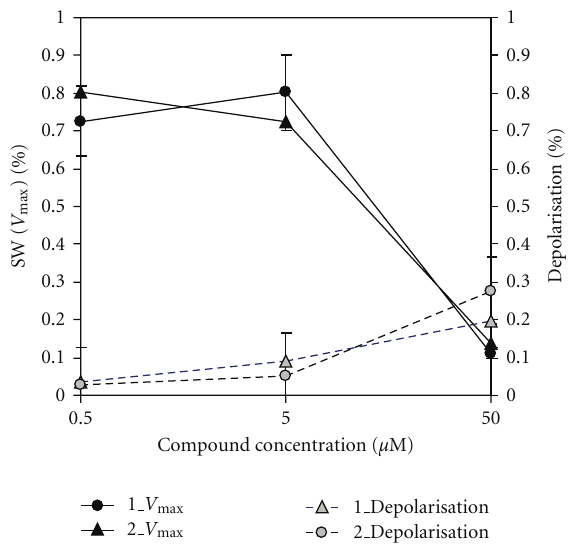
Figure 4: Influence of 0.1 mM ferrocenes 1 and 2 on mitochondrial swelling and transmembrane potential (the values were determined and expressed as % of control).